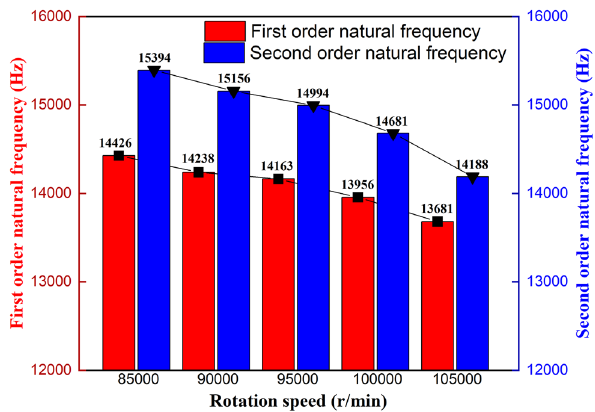
Figure 10: Change in fi rst and second order natural frequencies with increasing rotation speed during the second testing.